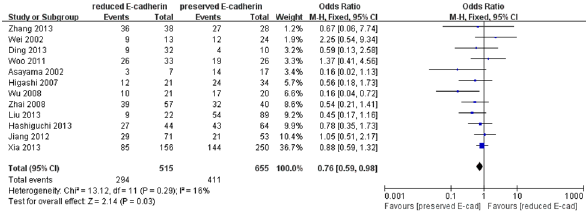
Figure 6. Forest plot displaying the results of the meta-analysis on vascular